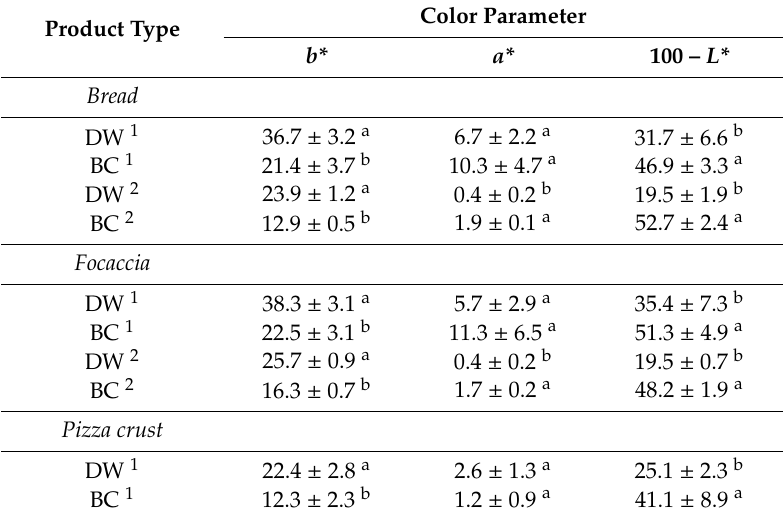
1 External color. 2 Internal color. Different letters in a column for the same bakery product and portion inspected, indicate significant differences ( p < 0.05).